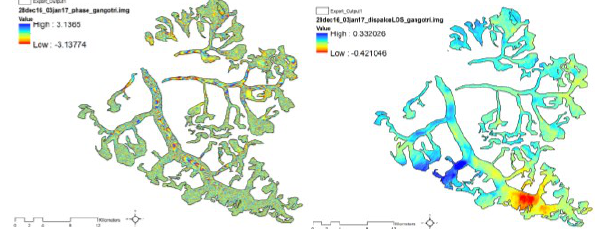
Figure 14. Interferogram and LoS glacier velocity for Gangotri Glacier using Sentinel-1 SAR data (Dec 2016-Jan.